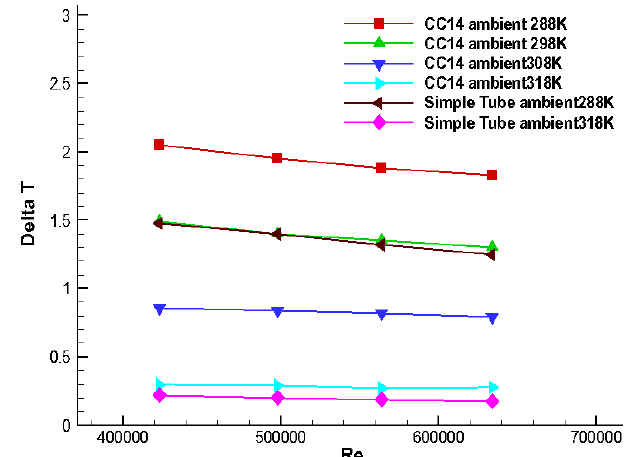
Fig. 13. Temperature difference of the tube in various ambient Fig .13 Temperature difference of the tube in various ambient temperatures